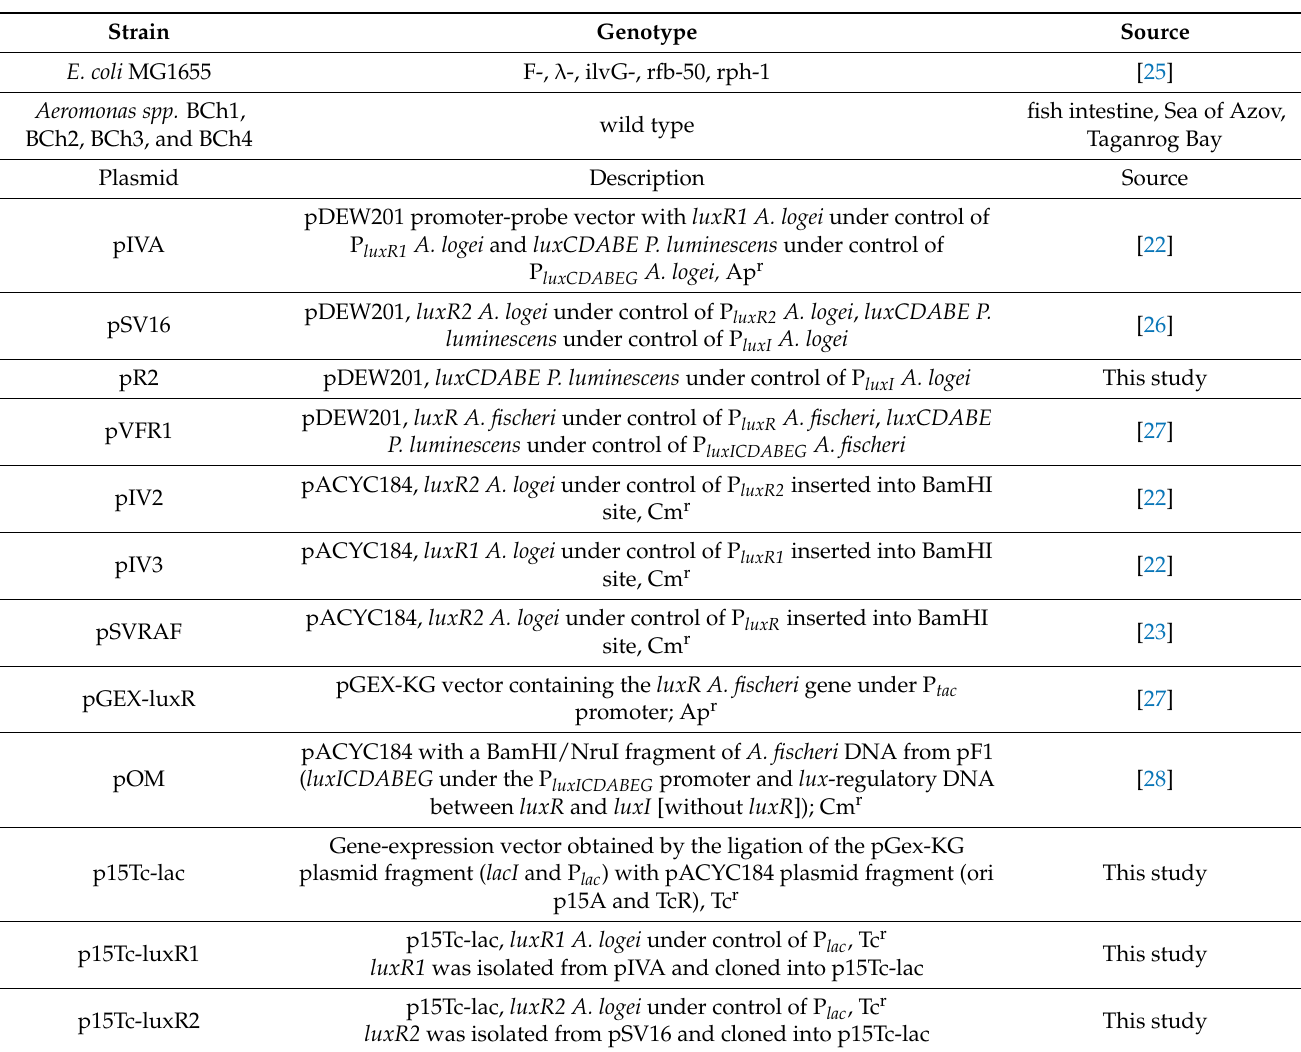
Table 1. Bacterial strains and plasmids used in the